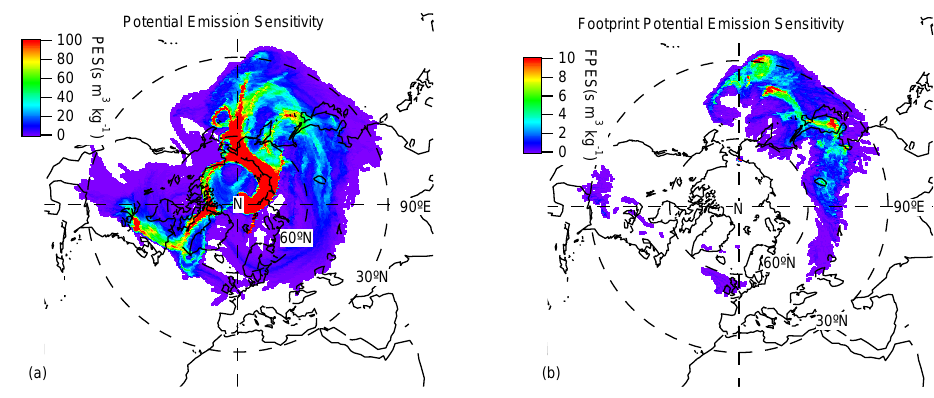
Figure 2. A typical example of (a) PES and (b) FPES from FLEXPART simulation from flight B759.